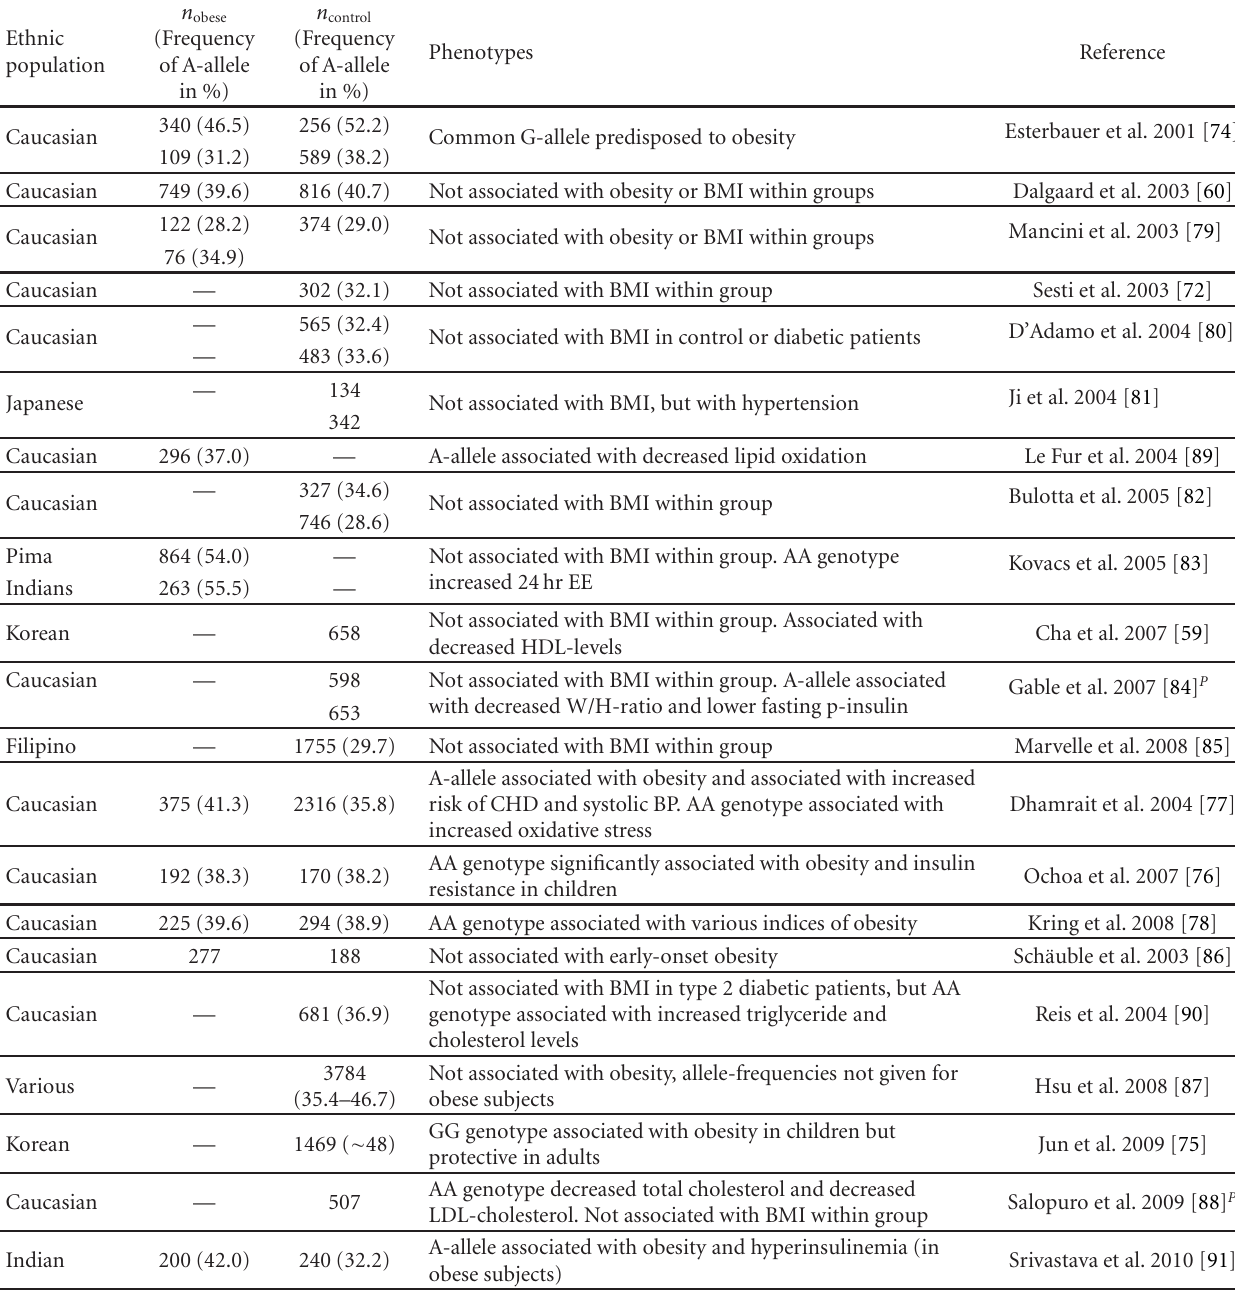
Table 2: Summary of association studies of the UCP2 promoter − 866G > A (rs659366) polymorphism in relation to obesity and related metabolic